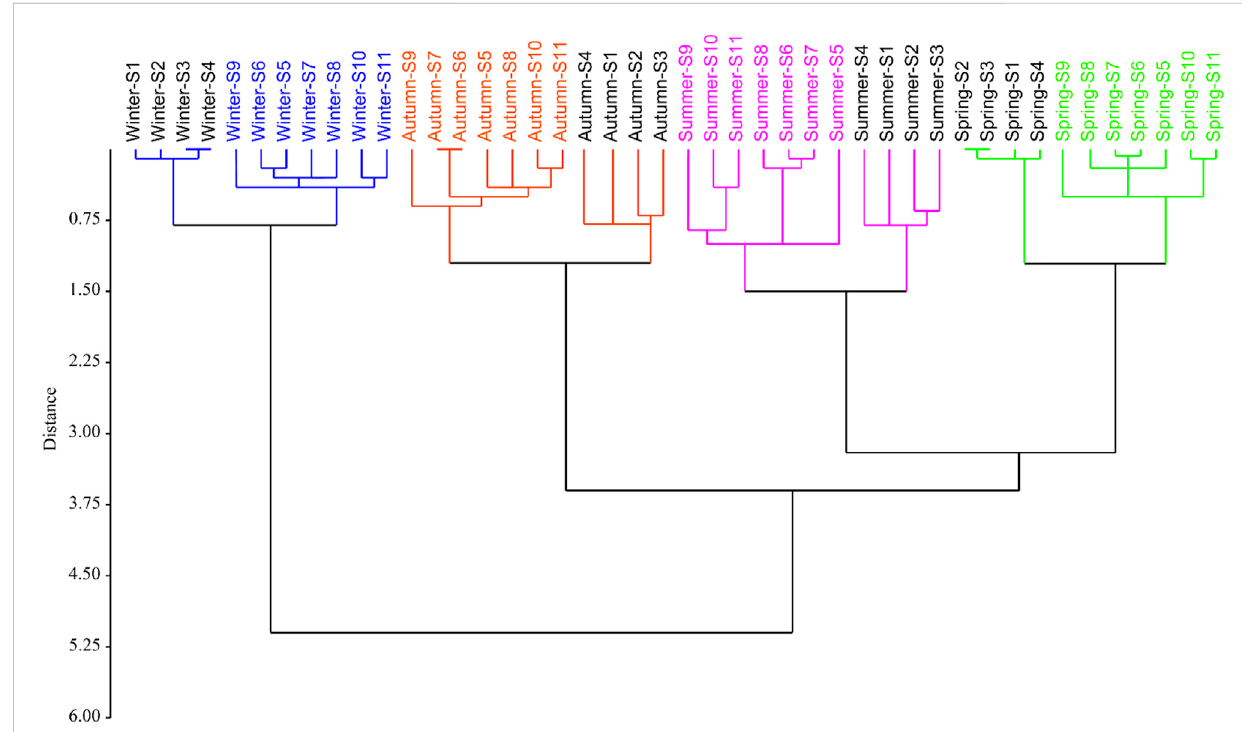
FIGURE 4 Dendrogram showing two clusters of sampling sites in four seasons using a single-linkage